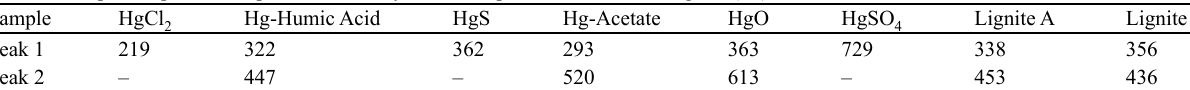
Table 3 Sample temperature at peaks of mercury release of pure substances and lignite (°C) Sample